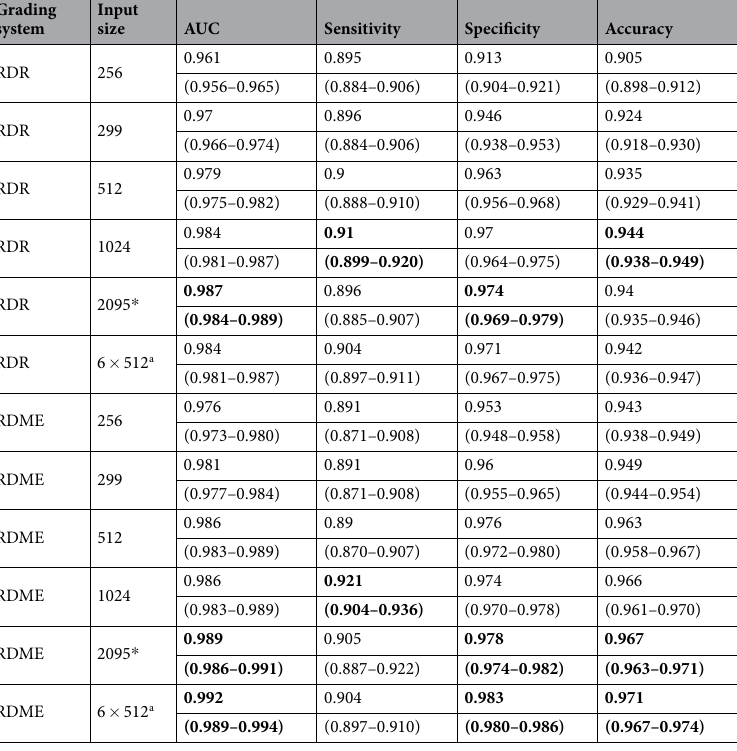
Table 4. Classification results for predicted of NRDR/RDR and NRDME/RDME with varying input image sizes on the primary validation set. Sensitivity, specificity and accuracy measured at 0.900 sensitivity operating point of tuning set. 95% exact Clopper-Pearson confidence interval in brackets. * Trained with model using instance normalization layers and an optimizer with accumulation of 15 mini-batches. a Ensemble of six classifiers trained on same data with same input